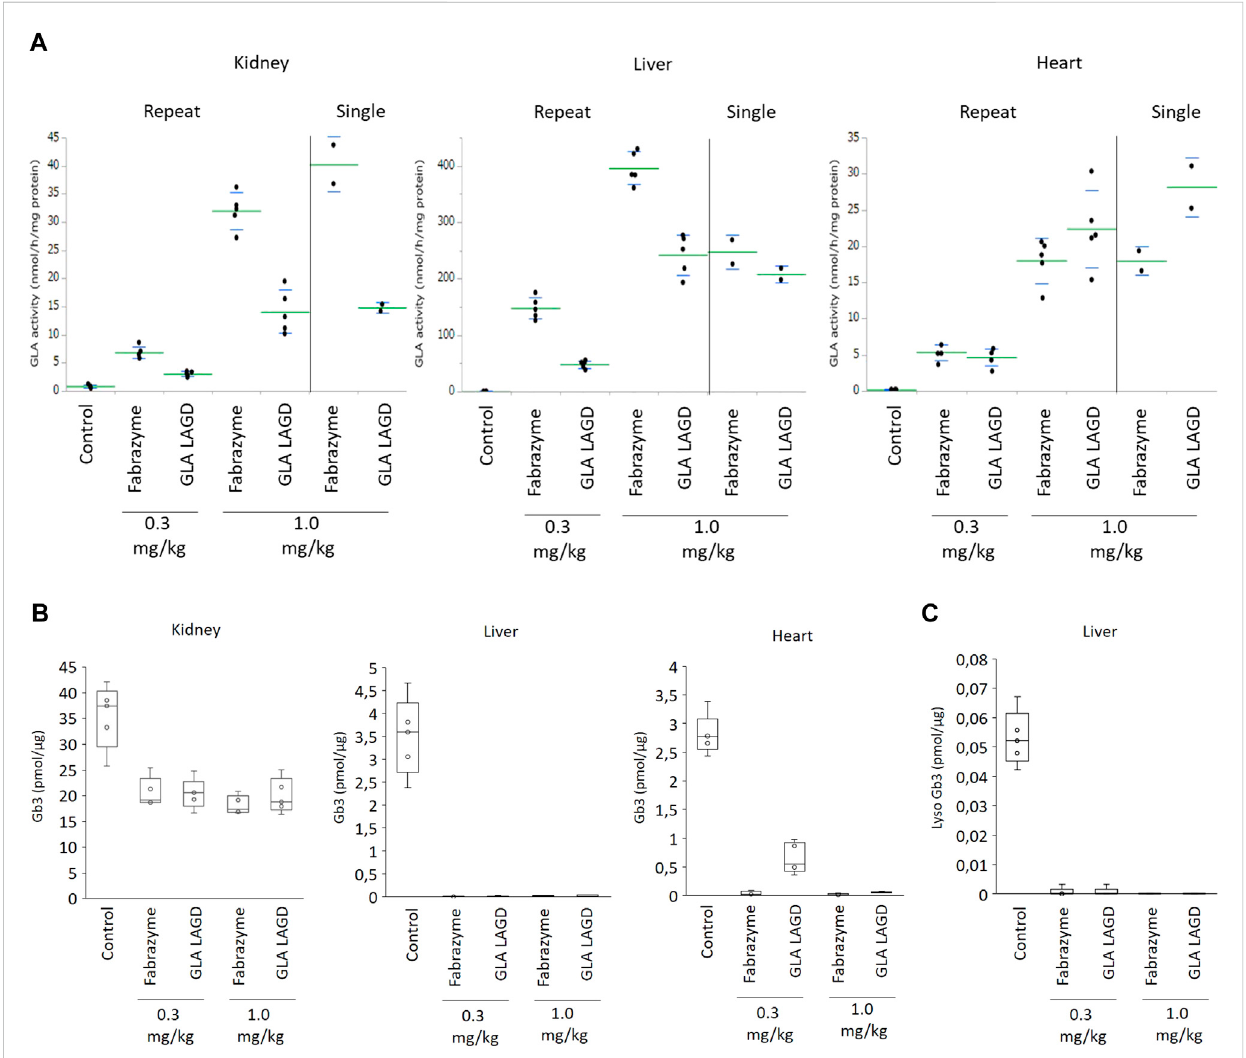
FIGURE 2 GLA activitiesand Gb3 analysis inrepeateddose study inFabry mouse model. (A) GLA enzyme activity represented as relative fl uorescence intensity in indicated organs of mice after infusion of 0.3 or 1.0 mg/kg Fabrazyme or GLA LAGD, or saline control (n = 5 in each group) every 2 weeks for 5 times. Included are data of single infusion studies at 1.0 mg/kg that were repeated to con fi rm fi ndings of our previous study (Tian et al., 2019). (B) Gb3 substrate level quanti fi ed by shotgun lipidomics MS analysis of the organs of mice mentioned above. (C) Lyso Gb3 level in liver of mice mentioned above quanti fi ed by shotgun lipidomics MS